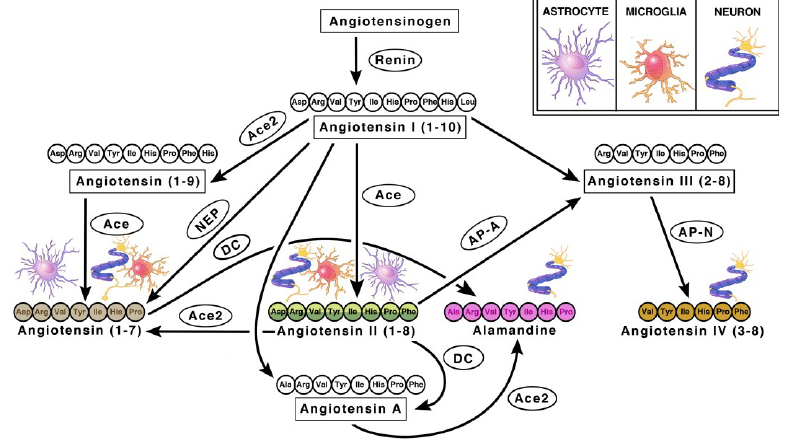
Figure 1. Schematic Diagram Depicting The RAS Components Within The Brain. Various brain cells possess different members of the RAS system which allows for the local synthesis and biological actions of angiotensin in the brain. The legend indicates the cells depicted within each illustration (astrocytes, neurons, and microglia). Enzymes convert precursor angiotensin fragments into neuroactive forms. Enzymes are indicated by circles. Neuroactive forms include: Angiotensins II, III, IV, (1–7), and Alamandine. The main biologically active forms are indicated with colored amino acid sequences. Abbreviations: angiotensin-converting enzyme (ACE) and (ACE2), aminopeptidase A